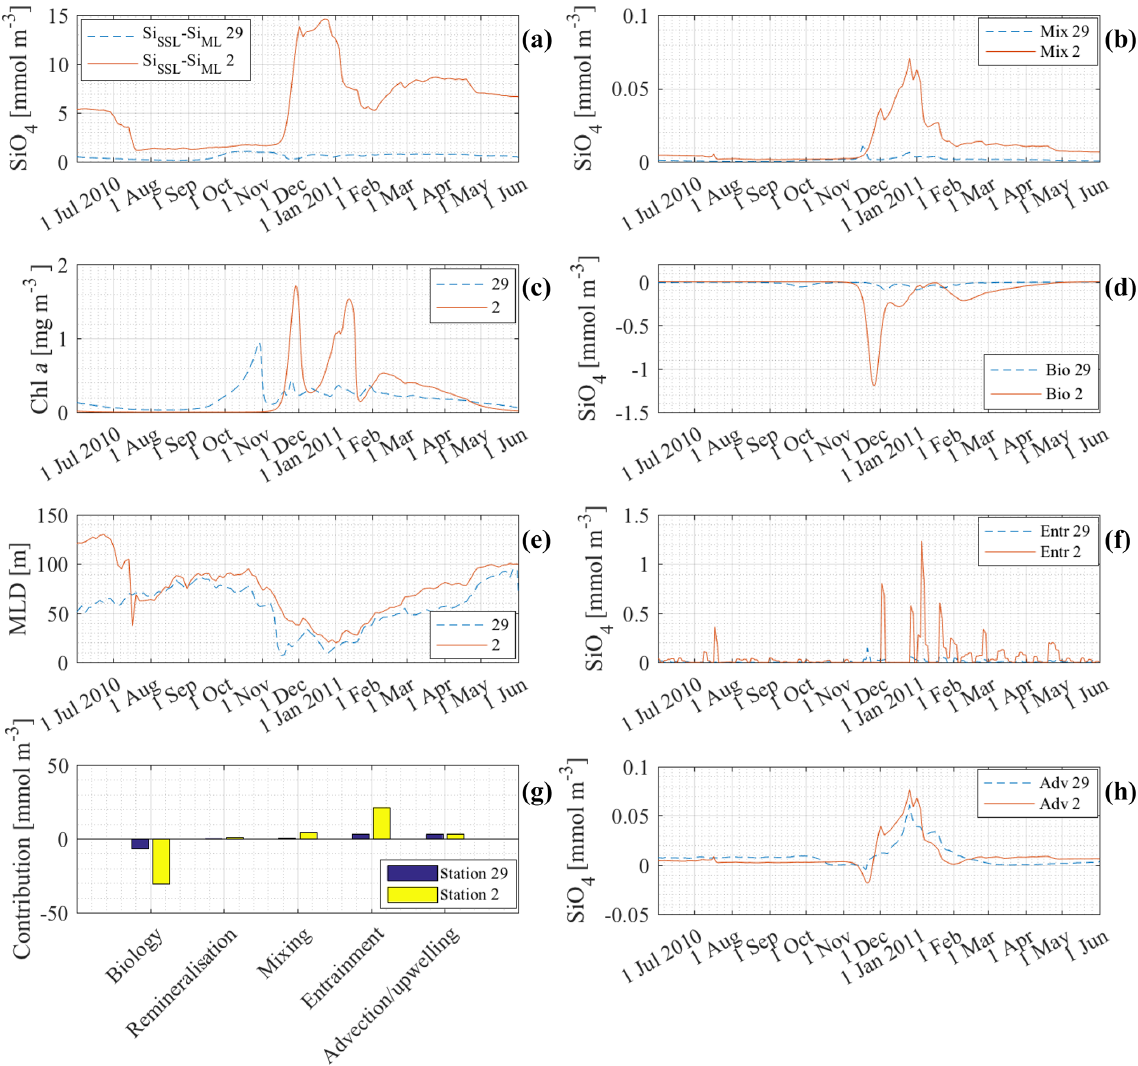
Figure 12. Comparison of model results at station 2 (63 ◦ ) and station 29 (41 ◦ S) between 1 June 2010 and 1 June 2011: (a) (cid:49) Si SSL − ML ; (b) contribution of mixing to the silicate concentration in the mixed layer; (c) chlorophyll a concentration in the mixed layer; (d) contribution of biology and remineralisation to the silicate concentration in the mixed layer; (e) mixed-layer depth; (f) contribution of entrainment to the silicate concentration in the mixed layer; (g) cumulative contribution of each process from 1 June 2010 to 1 June 2011; (h) contribution of advection–upwelling to the silicate concentration in the mixed